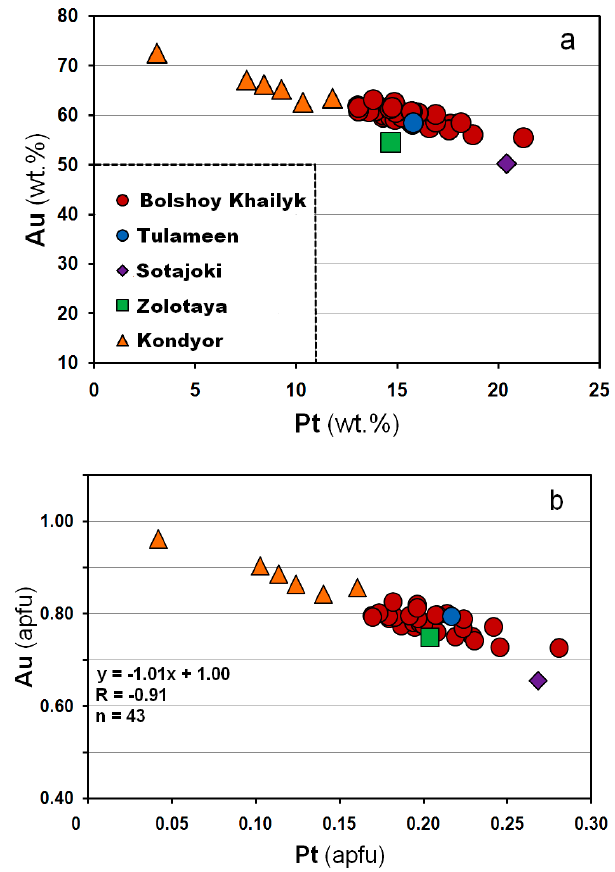
Figure 3. Plots of Pt vs. Au expressed in weight % ( a ) and values of atoms per formula unit (apfu), on the basis of a total of 2 apfu ( b ), showing compositional variations in grains of tetra-auricupride from Bolshoy Khailyk (this study) and various localities reported in the literature.